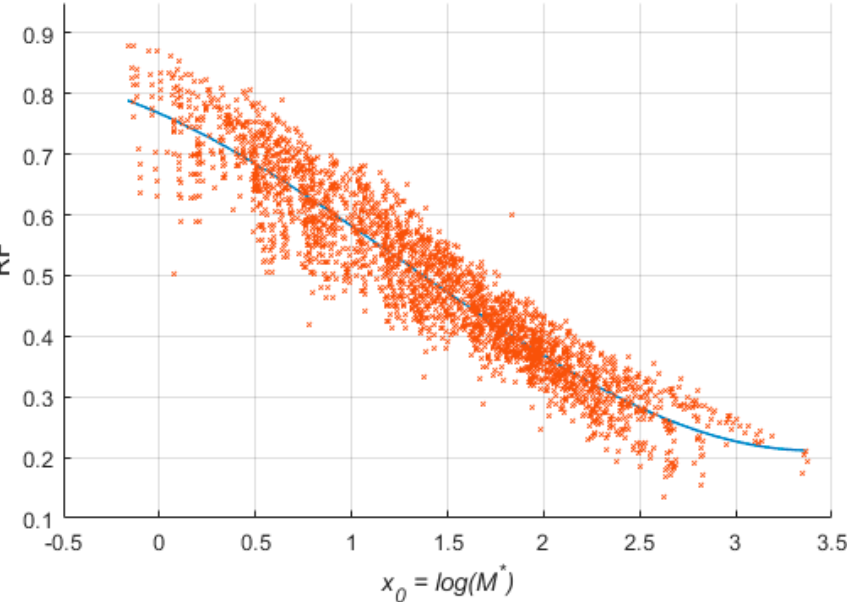
Figure 3. Datapoints plotted against corresponding values of x 0 for MOD1, defined using a third- order polynomial (blue line) of x 0 .